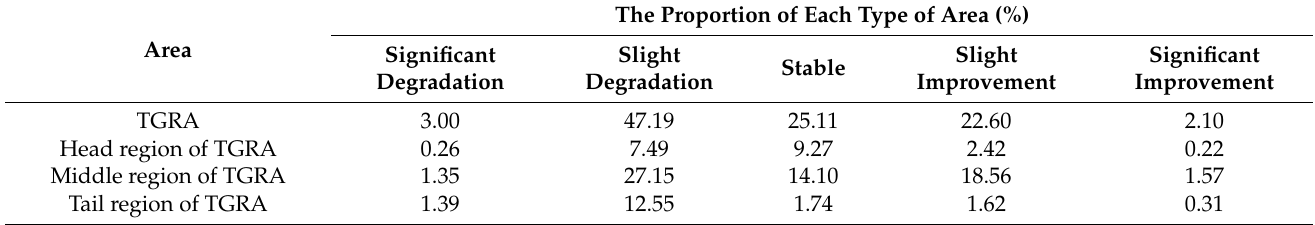
Table 6. Statistics on the area of difference in habitat quality from 2000 to 2020.